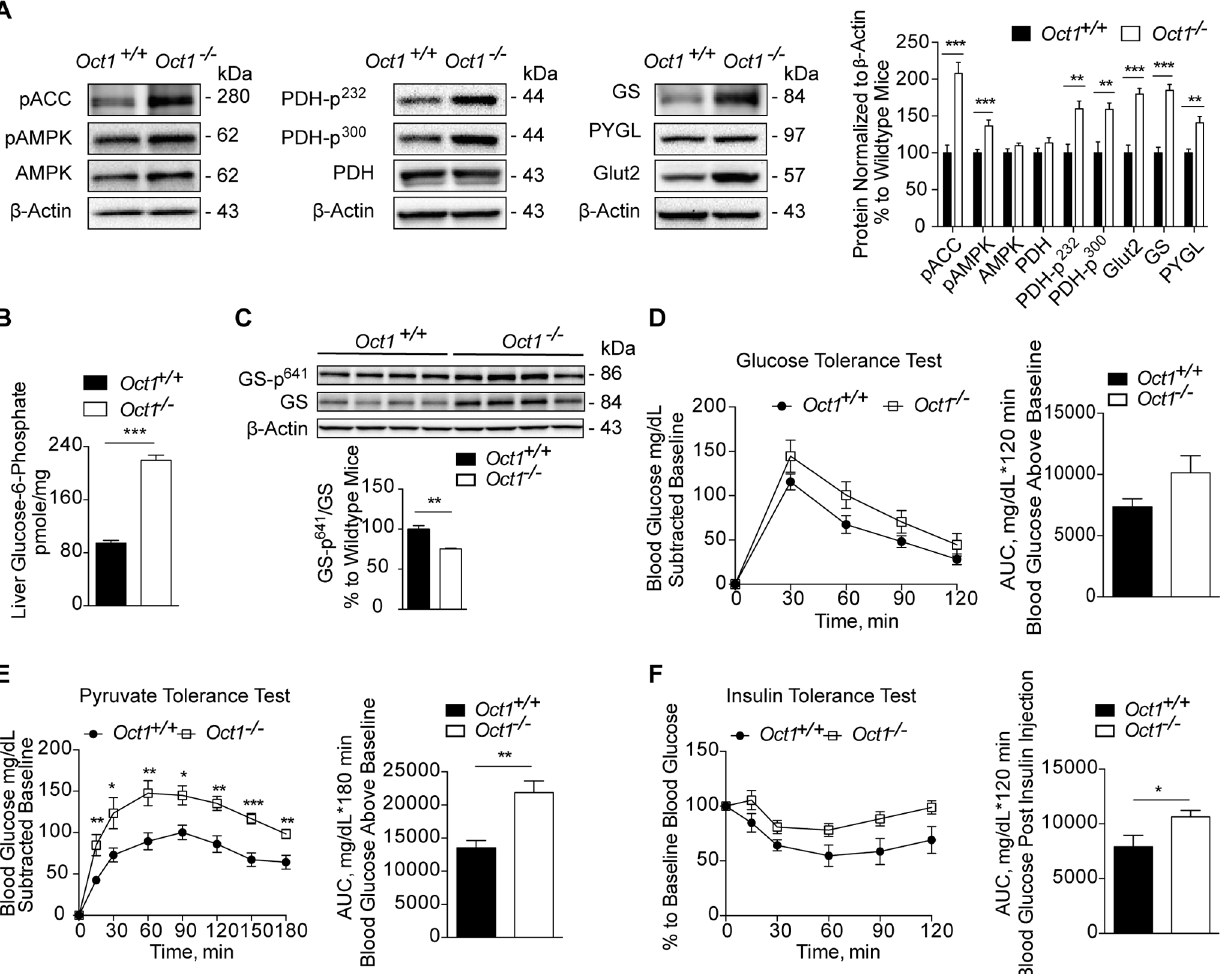
Fig 4. Deletion of Oct1 altered hepatic glucose metabolism. (A) Representative western blots of key proteins involved in energy metabolism in mouse liver. Quantification of the western blots is shown in the right panel ( n = 4–10 mice per genotype). (B) Hepatic glucose-6-phosphate levels ( n = 4 per genotype). (C) Western blot of GS-p 641 , GS, and loading control β -actin. Mice were fasted overnight for 16 hours for (A), (B), and (C). (D) GTT in mice fasted for 5 hours, adjusted for baseline, and associated glucose AUC ( n = 10 per genotype). (E) PTT in mice fasted for 16 hours, adjusted for baseline, and associated glucose AUC ( n = 6 per genotype). (F) ITT in mice fasted for 5 hours and associated glucose AUC ( n = 6 per genotype). Data shown are mean ± SEM. Data were analyzed by unpaired two-tailed Student t test; (cid:3) p < 0.05, (cid:3)(cid:3) p < 0.01, and (cid:3)(cid:3)(cid:3) p < 0.001. Underlying data are provided in S1 Data. AMPK, AMP-activated protein kinase; AUC, area under the curve; Glut2, glucose transporter 2; GTT, glucose tolerance test; GS, glycogen synthase; GS- p 641 , phospho-glycogen synthase at S641; ITT, insulin tolerance test; Oct1 ,organic cation transporter 1; pACC, phosphorylate acetyl-CoA carboxylase; pAMPK, phosphorylate 5’ adenosine monophosphate-activated protein kinase; PDH, pyruvate dehydrogenase; PDH-p, phospho-pyruvate dehydrogenase; PTT, pyruvate tolerance test; PYGL; glycogen phosphorylase.